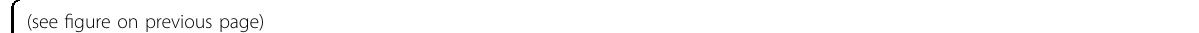
Fig. 1 Activation of Wnt signal induces midbrain characteristics in human ESC-derived NPCs. a Ef fi cient induction of neural rosette cells from human ESCs by co-treatment with dorsomorphin and SB431542. b Strong immunoreactivity for SOX1 and Nestin in neural rosette cells. Morphology of neural rosette cells expanding in either the absence ( c ) or the presence of 1 μ M BIO ( d ). e NPCs treated with BIO maintained immunoreactivity for SOX1 and Nestin. f Treatment with BIO upregulated EN1 expression and downregulated expressions of BF1 and GBX2 in dose-dependent manner. g BIO treatment signi fi cantly increased the number of EN1-positive neural cells. h The inductive effect of BIO treatment on midbrain fate appeared to be more speci fi c than that of FGF8. i Expression pattern of another set of regional markers ( SIX3 for forebrain; PAX2 for midbrain; and HOXA2 for hindbrain) supported the midbrain-biased fate of NPCs treated with BIO. Treatment with other known GSK3 inhibitors, 1-AKP ( j ) and LiCl ( k ), resulted in regionalization comparable to BIO treatment. l Treating NPCs with Wnt antagonists (100 ng/ml DKK-1 and 500 ng/ml frizzled-5) downregulated the endogenous level of EN1 transcript in NPCs. m Immunoblot for β -catenin and EN1 protein after introduction of two different β -catenin-speci fi c shRNAs (shRNA-1 and shRNA-2). EN1 protein level was directly downregulated by β -catenin knockdown. β -actin was a loading control. All data are expressed as mean ± S.E.M. Statistical signi fi cance was estimated using Student ’ s t test ( g , i , j , and k ) or one-way ANOVA ( f , h , and l ) from at least three independent experiments; * p < 0.05, ** p < 0.01. Scale bar: 200 μ m for a , c , and d ; 50 μ m for b , e , and